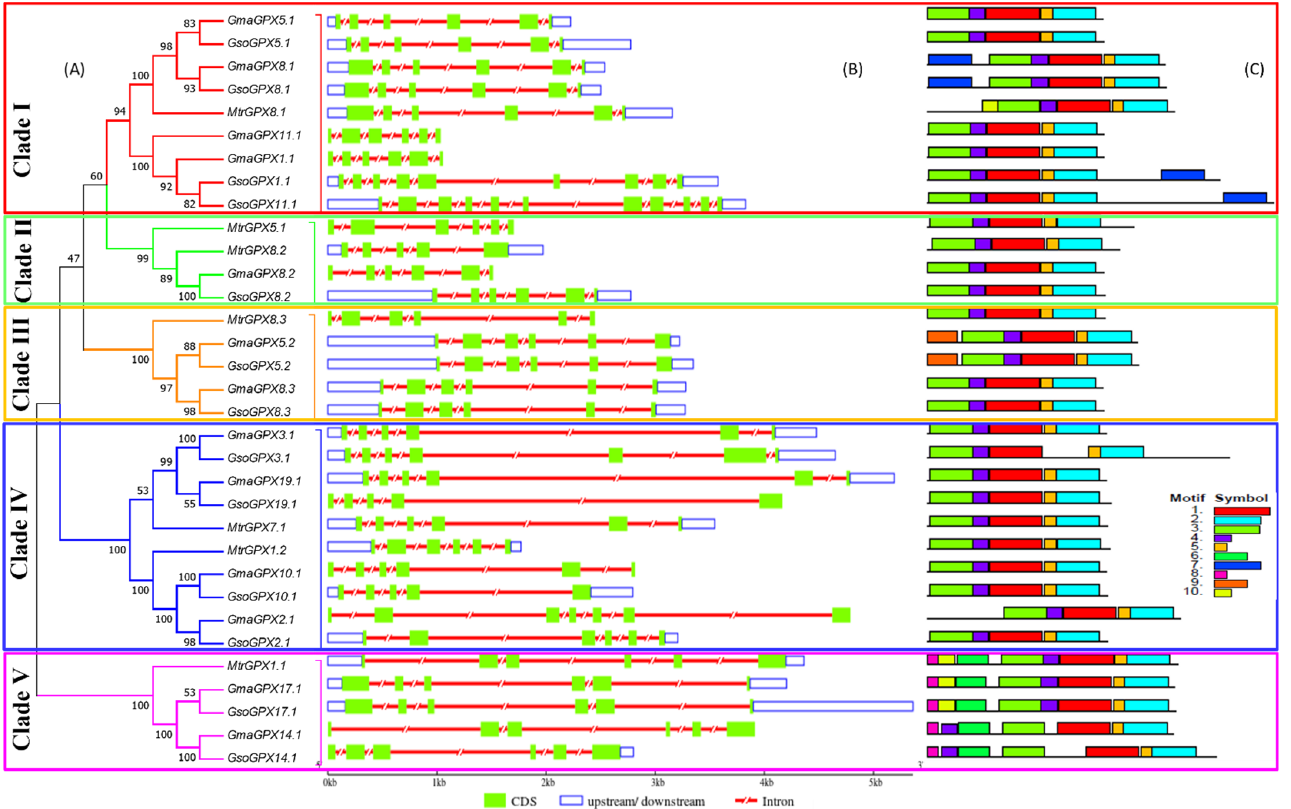
Figure 4. Phylogenetic relationship, exon–intron distribution/gene structure and conserved motifs in the GPX gene family in G. max , G. soja and M. truncatula . ( A ) The phylogenetic tree of GPX gene family classified into 5 clades represented with different colors of boxes on the phylogenetic tree (Clade I-V). ( B ) The untranslated region (UTRs), intron and exon distribution is represented with unfilled blue boxes, red shrinked lines and green boxes, respectively. ( C ) Identification of the conserved motifs in GPX genes. Each motif is presented with a particular color.